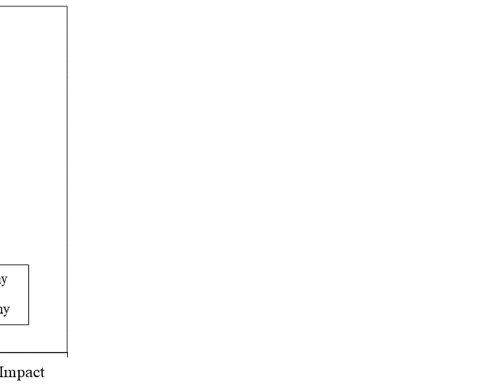
Figure 3. Relationship between individual job impact and work engagement moderated by auton- omy.